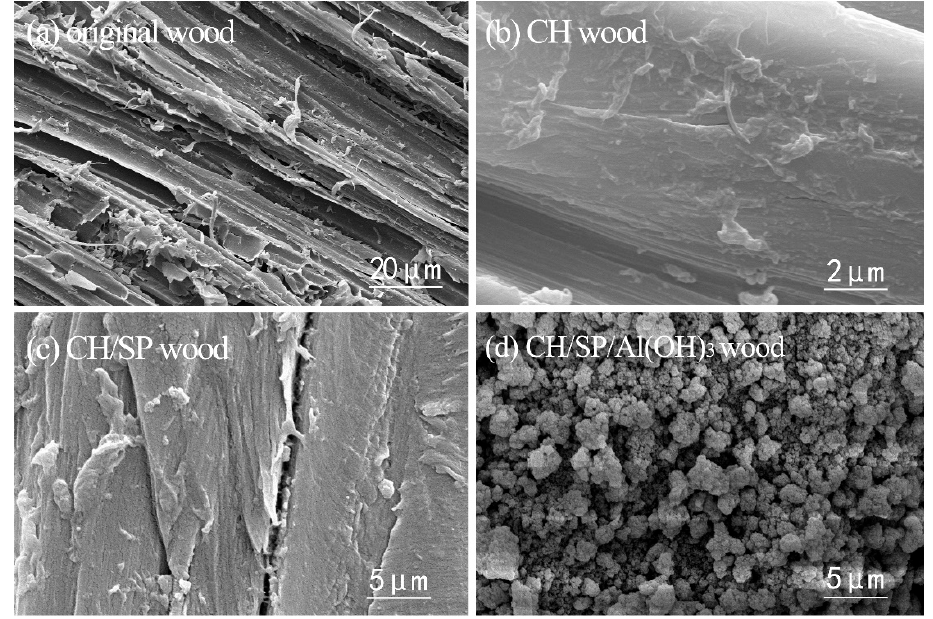
Figure 2 . SEM images of ( a ) original wood; ( b ) CH wood; ( c ) CH/SP wood and ( d ) CH/SP/Al(OH) 3 Figure 2. SEM images of ( a ) original wood; ( b ) CH wood; ( c ) CH/SP wood and ( d ) wood. CH/SP/Al(OH) 3 wood.